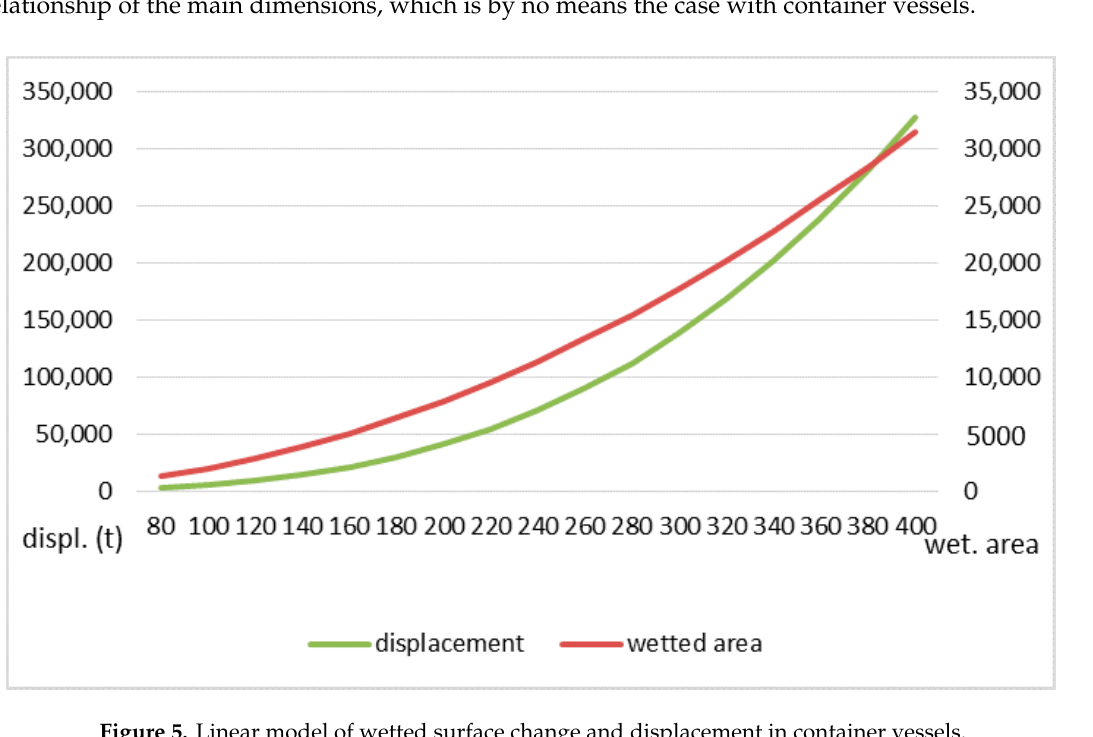
Figure 5. Linear model of wetted surface change and displacement in container